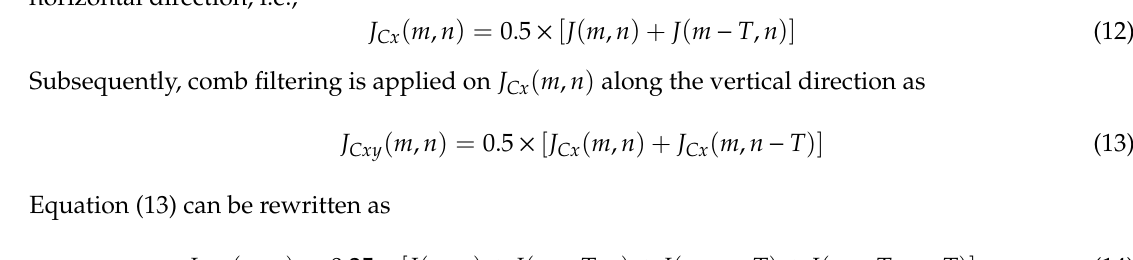
Figure 5. ( a ) Frequency spectrum of a signal in Figure 2a being down-sampled by τ = 4 times (solid line), and the transfer function of a comb filter with delay T = spectrum of the down-sampled signal after filtering with the comb filter.